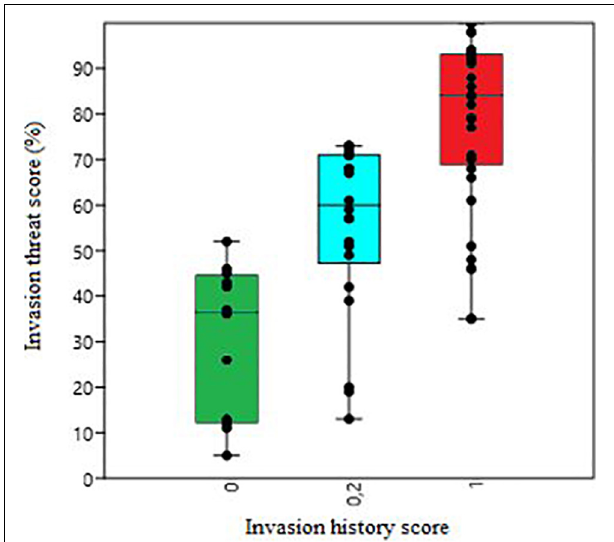
FIGURE 3 | The NIS invasion threat score percentages obtained for each of the groups based on species invasion history score. Group 0 (for those species only present in their native habitat and without known introduction events), group 0.2 (for species that have been introduced outside their native range but do not cause any known impact) and group 1 (for those species that have invaded new areas and cause various impacts of different